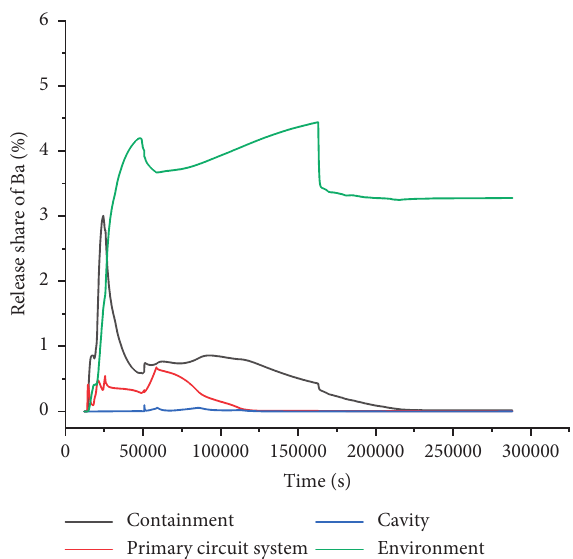
Figure 20: Distribution of Ba in different position.